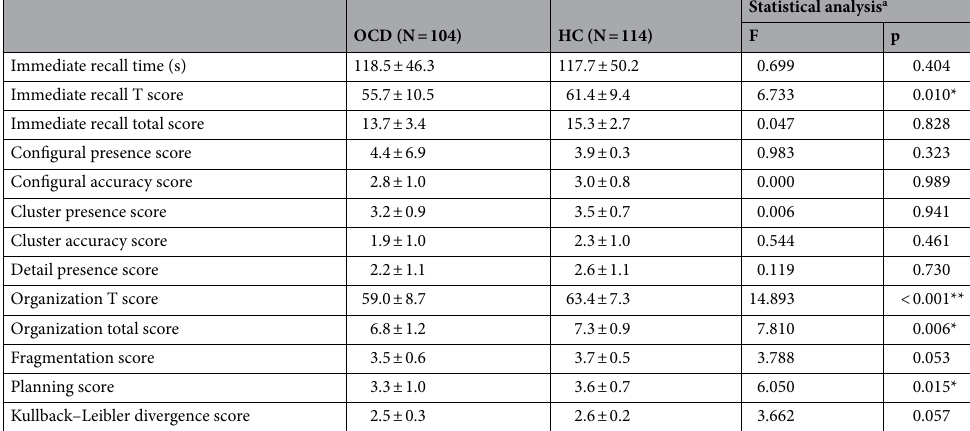
Table 2. Comparison of the Rey–Osterrieth complex figure test (RCFT) results across the patients with obsessive–compulsive disorder (OCD) and healthy controls (HCs). Data are given as the mean ± standard deviation. *The mean difference is significant at the 0.05 level. **The mean difference is significant at the 0.005 level. a Analysis of covariance (ANCOVA) using education years and intelligence quotient (IQ) as covariates for group comparisons of T scores. ANCOVA using age, sex, education years, and IQ as covariates for group comparisons of other variables.